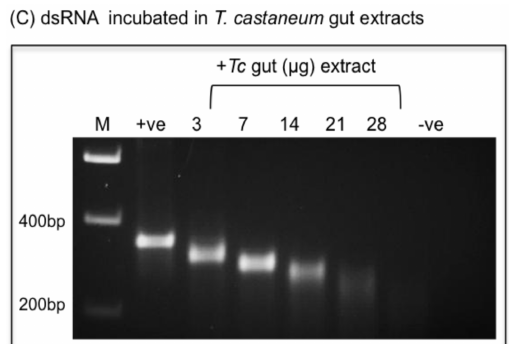
Figure 6. In vitro stability of dsRNAs. ( A ) dsRNA (200 ng) incubated in the presence of A. pisum ( Ap ) or T. casteneum ( Tc ) cell free haemolymph (25 µ g protein); − ve controls are Ap or Tc haemolymph alone. ( B ) ( i ) 200 ng dsRNA (R) or dsDNA (D) incubated with 3 µ g Ap or Tc gut extract for 1 and 5 min. +ve denotes dsRNA and dsDNA control (i.e., no added protein), − ve control is gut extract alone. ( B ) ( ii ) Inhibition of dsRNA degradation in Ap gut extract. Samples were incubated for 5 min at 25 ◦ C; +ve control is dsRNA in MOPS buffer; +Ex is dsRNA incubated with 3 µ g Ap gut protein; +H is dsRNA incubated with heat treated (65 ◦ C for 10 min) Ap gut extract (3 µ g protein); +ED is dsRNA incubated with gut extract in MOPS buffer with 20 mM EDTA. ( C ) dsRNA (200 ng) incubated for 30 min with increasing amounts of T. castaneum gut protein (as